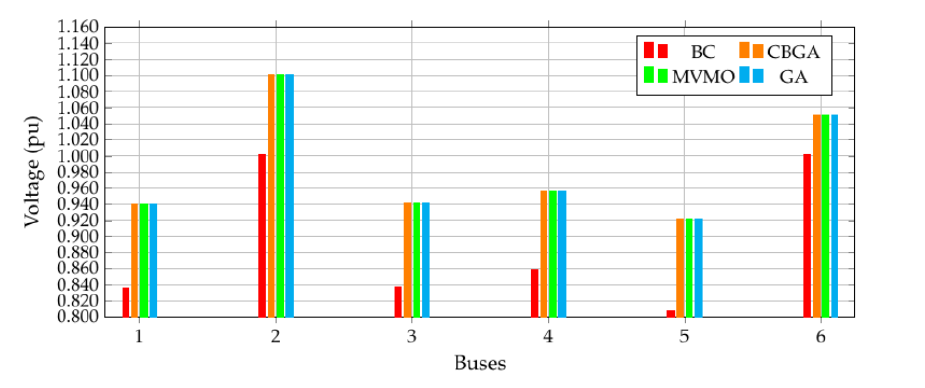
Figure 10. Voltage profile of the IEEE 6-bus test system considering different